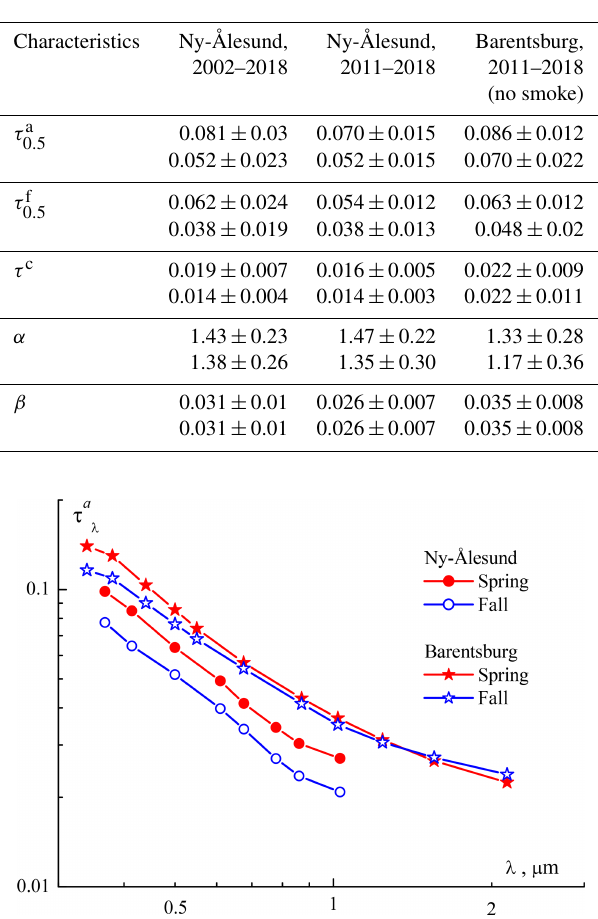
Table 4. Average AOD characteristics ( ± SD) in Ny-Ålesund and Barentsburg during the spring (April–May) maximum (first row in each horizontal panel) and fall (August–September) minimum (sec- ond row in each horizontal panel).